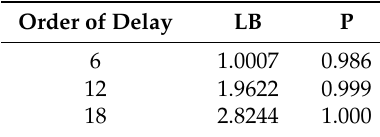
Table 15. Residual sequence test of ARMA (25,